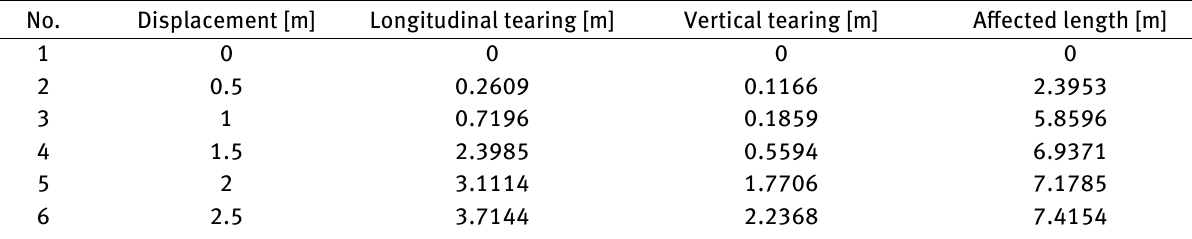
Table A.4: Summary of the damage assessment on the DSS: impact to the outer shell